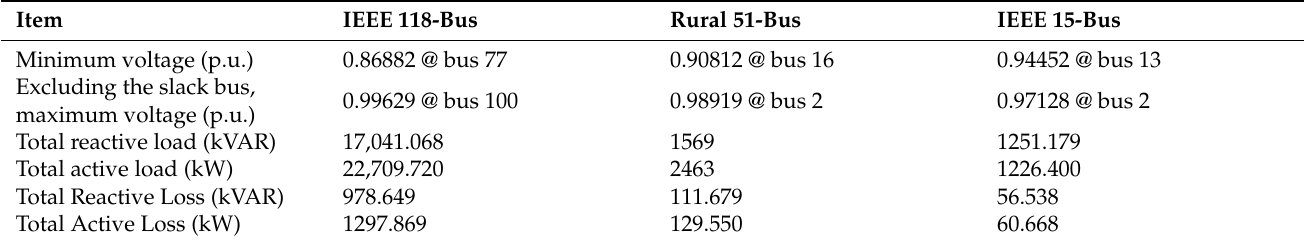
Table 2. Specifications of the studied networks.